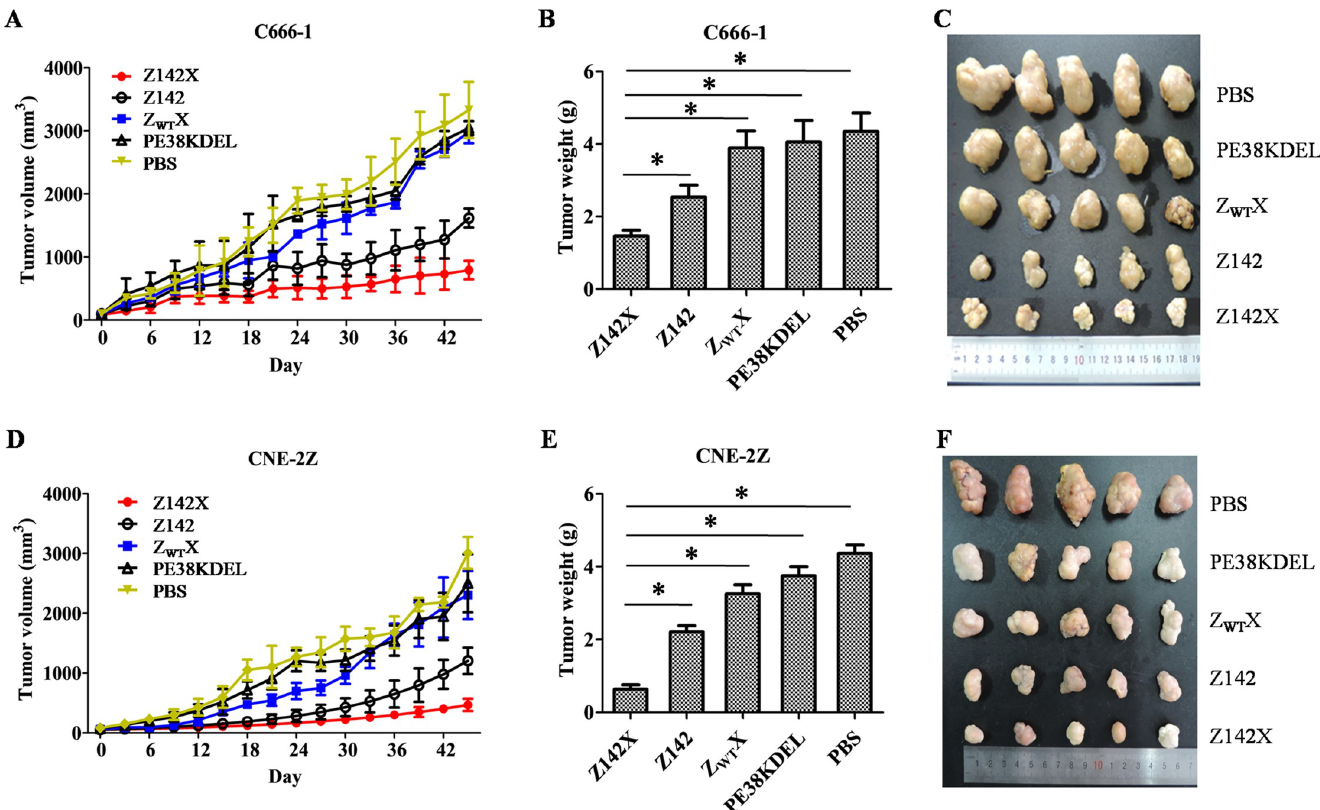
Fig 6. Z142X affitoxin prevents EBV tumor growth in mice bearing C666-1 (A-C) or CNE-2Z (D-F) tumor xenografts. Mice bearing C666-1tumor grafts were intravenously injected with 100 nmol/kg Z142X, Z142, or an equal amount of control agents or the same volume of PBS every two days for 15 times via tail vein. Tumor growth was monitored by measuring the tumor volume every day. The average tumor sizes increased rapidly in the control groups, while the tumor in the Z142X affitoxin- or Z142 affibody-treated animals displayed remarkable growth inhibition. At the end of the experiment, all tumor grafts were removed and weighed. The average tumor weights in Z142X-treated animals were significantly lower than that in the control mice. Similar to the mice bearing subcutaneously CNE-2Z tumor xenografts, Z142X affitoxin was a much stronger inhibitor than that of control agents. Z142 affibody did exert inhibitory activity to tumor growth. The control agents (Z WT X, PE38KDEL or PBS) did not show anti-tumor effect on these mice. Data represent the mean ± SD (n = 5). � P < 0.05, compare to the PBS, PE38KDEL, Z WT X, Z142 affibody groups. 2-tailed unpaired Student’s t test was used.